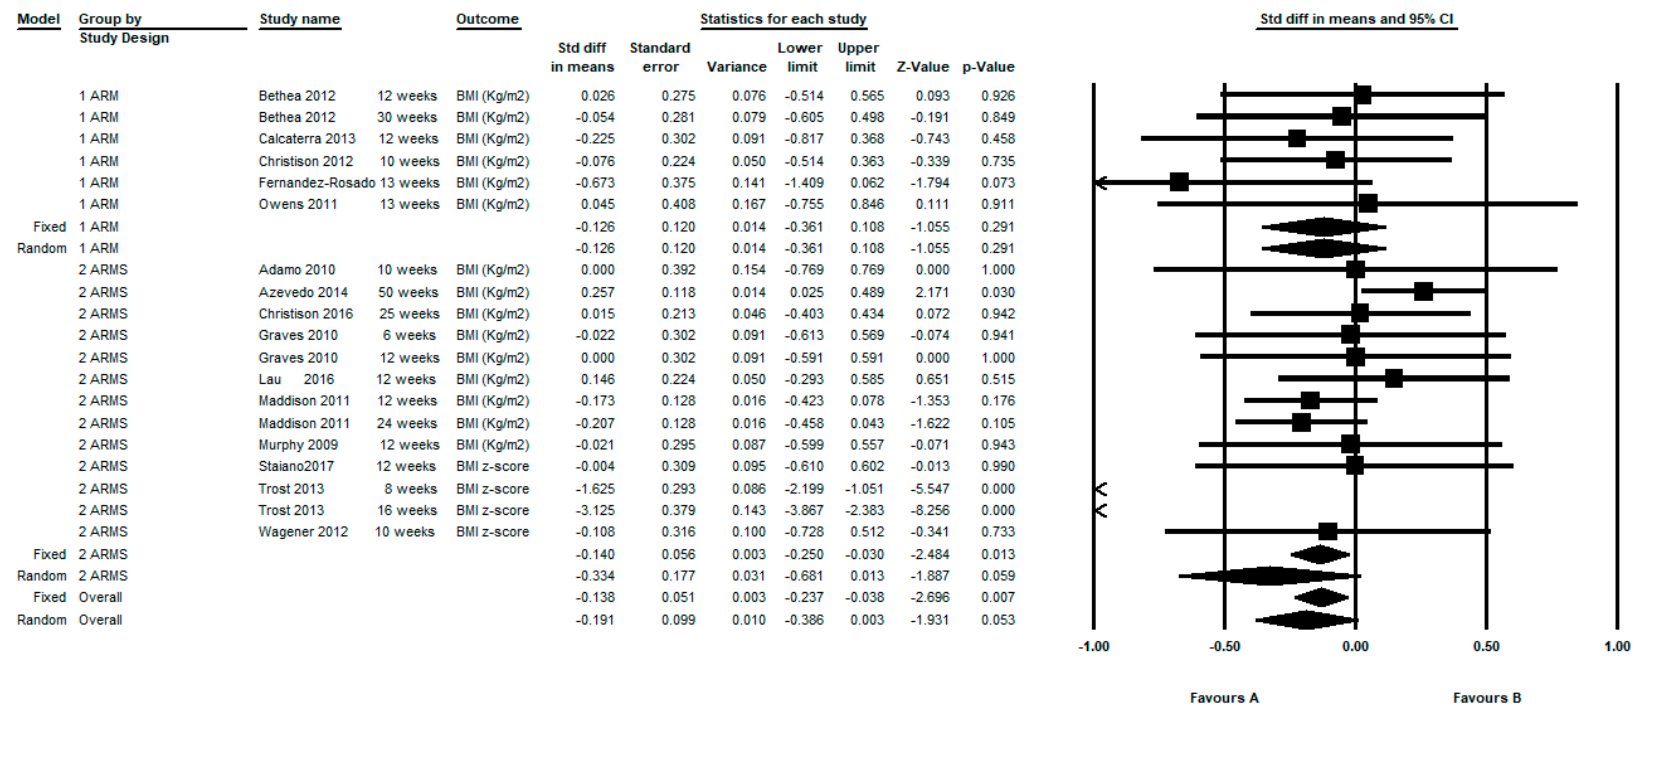
Figure 2. Pre-post intra-group difference in BMI in the group intervened with active video games. All measurements and all follow-ups.